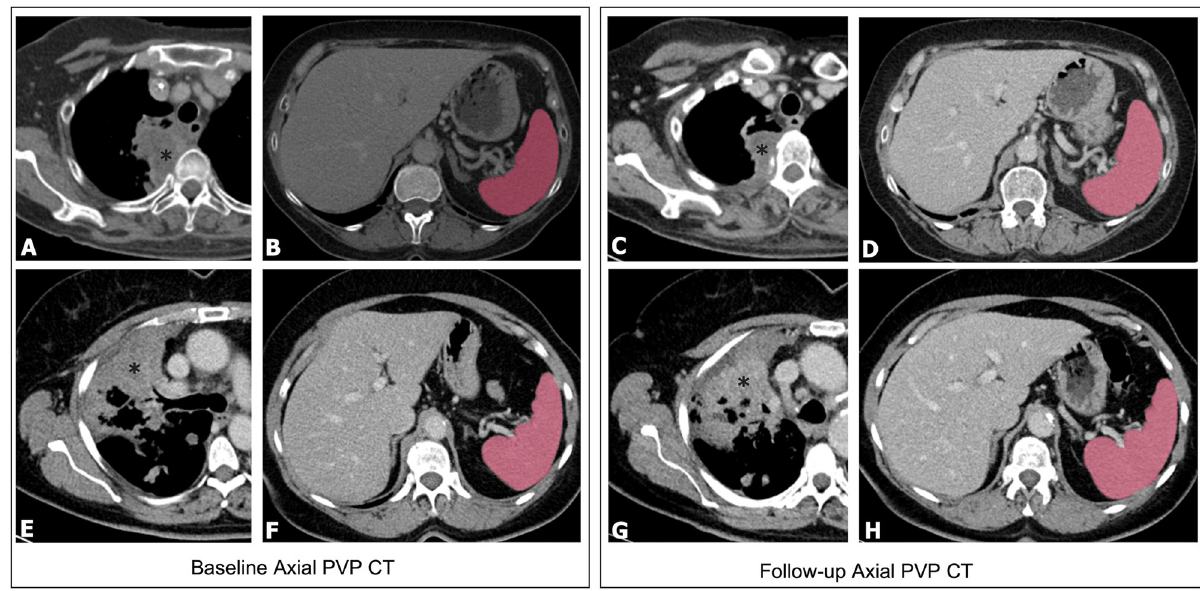
Fig 1. Representative computed tomography (CT) images used to calculate spleen volume. Non-small cell lung cancer ( � ). Baseline axial CT scans and follow-up scans in a responder patient (A-D) and a non-responder (E-H).